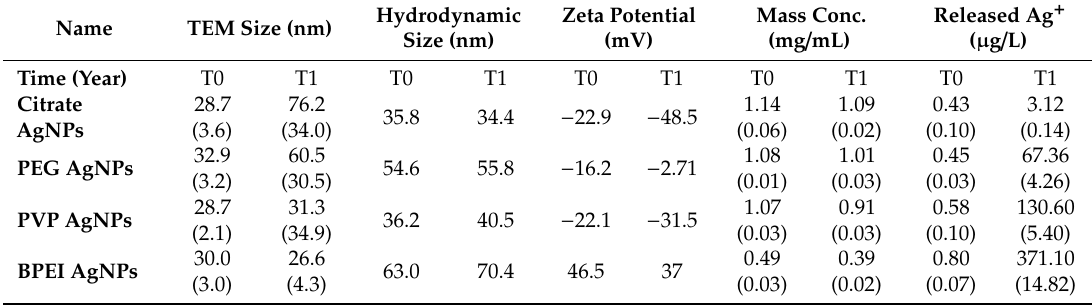
Table 1. Characterization of initial AgNPs and AgNPs stored for 1 year in a fridge (mean (SD), n = 3). The PI of DLS in each medium was less than